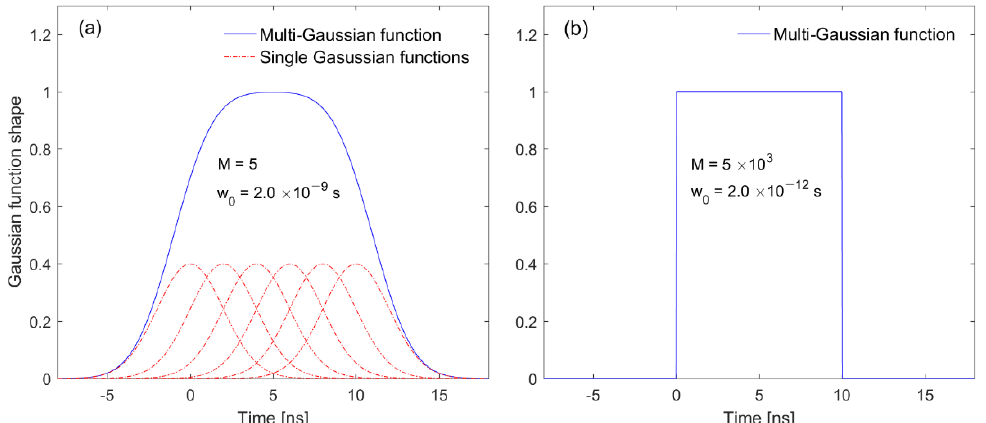
Figure 1. Pulse shapes of the entire FMGB depending on the orders. Pulse shapes for M = 5 ( a ) and 5000 M = ( b ), respectively.